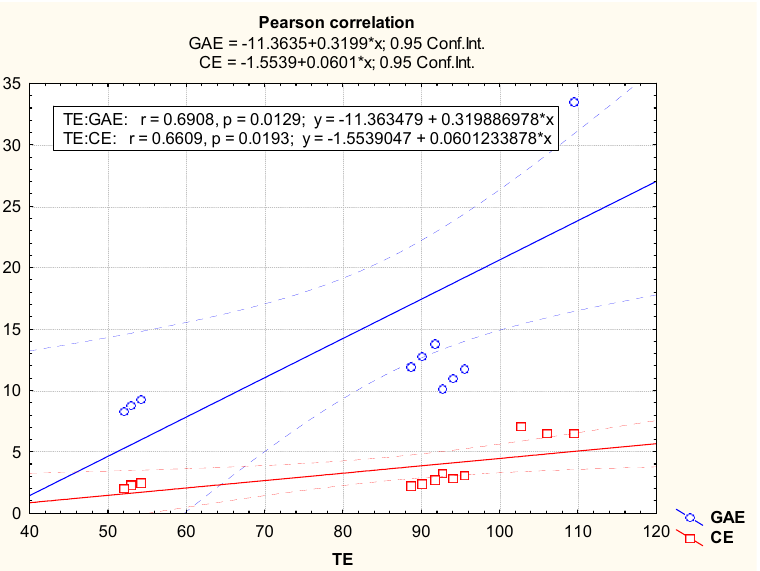
Figure 2. The Pearson correlation between radical scavenging capacity (expressed as TE) and total phenolic content (expressed as GAE), as well as between radical scavenging capacity (expressed as TE) and total flavonoid content (expressed as CE).